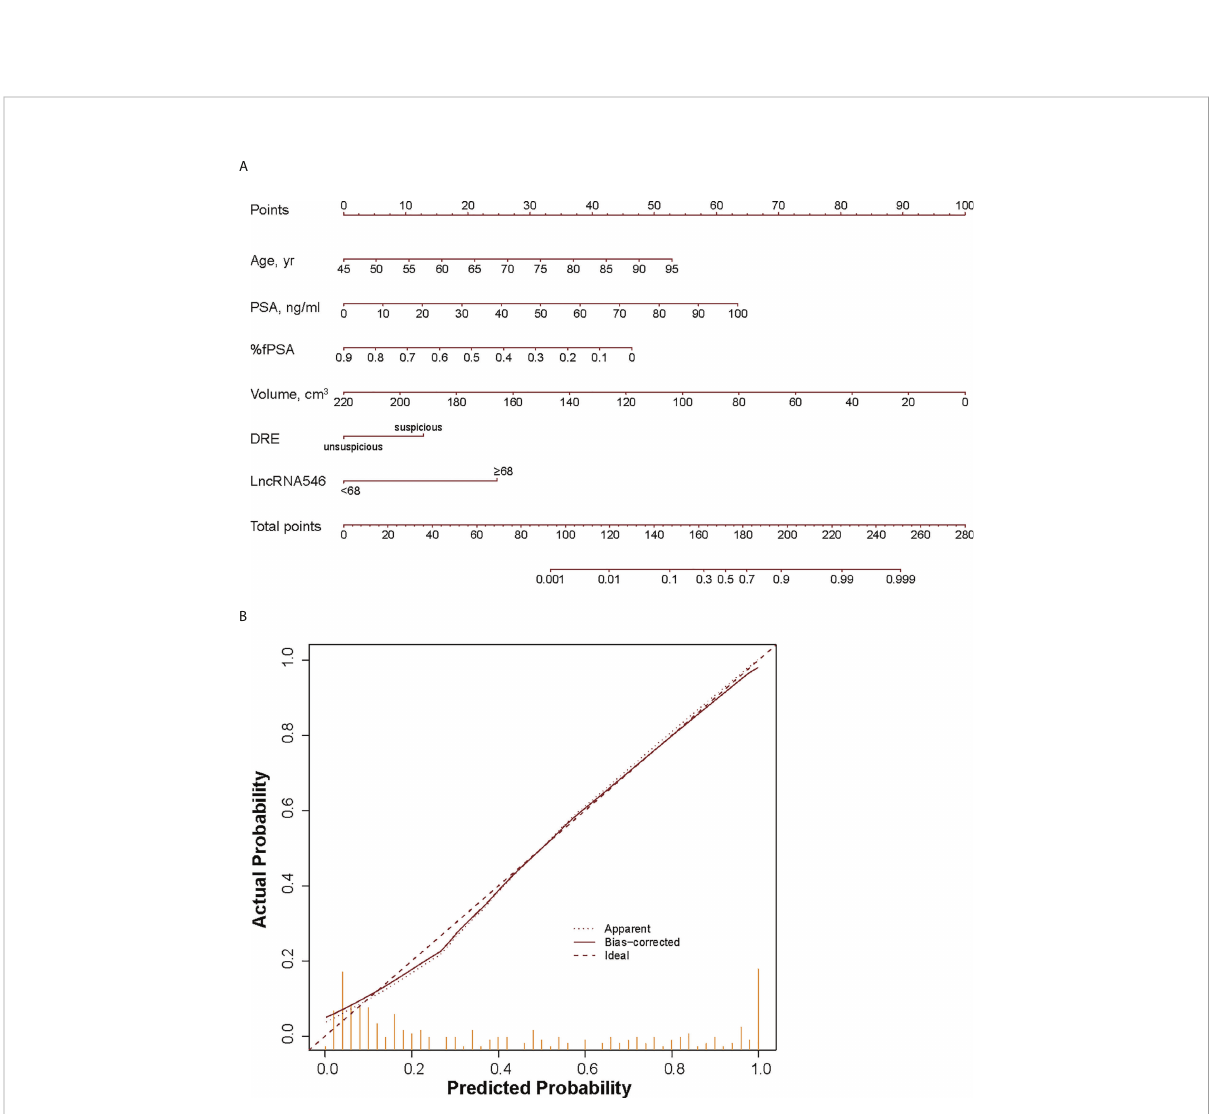
FIGURE 7 Development (A) and calibration curve (B) of LncRNA546 nomogram for early diagnosis of PCa. yr, year; %fPSA, percent free PSA; DRE, digital rectal examination.